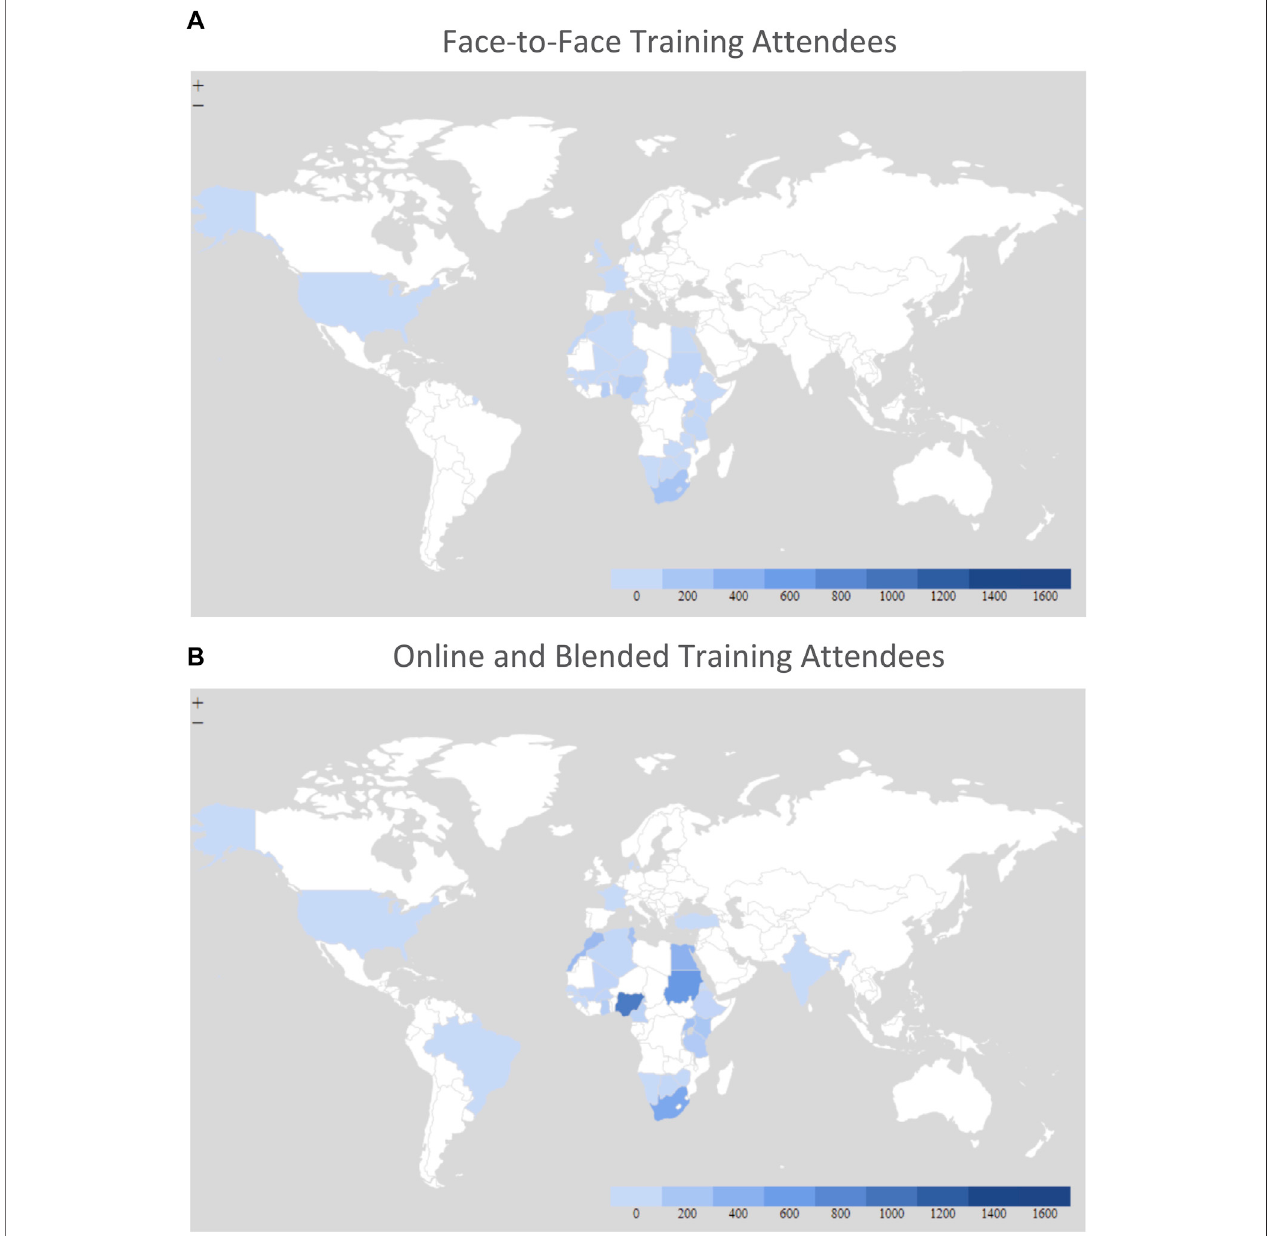
FIGURE 4 | Map showing the distribution of the country of residence for all individuals who have attended any H3ABioNet training event. (A) is for face-to-face training events, while (B) is for online and blended training events. The darker the shade of blue, the higher the number of individuals. Note: A number of individual ’ s country of residence was not collected especially in early training events; as a result, in (A) 437 individuals (34%) are not represented on the map. In (B) 977 individuals (19.5%) are not represented on the